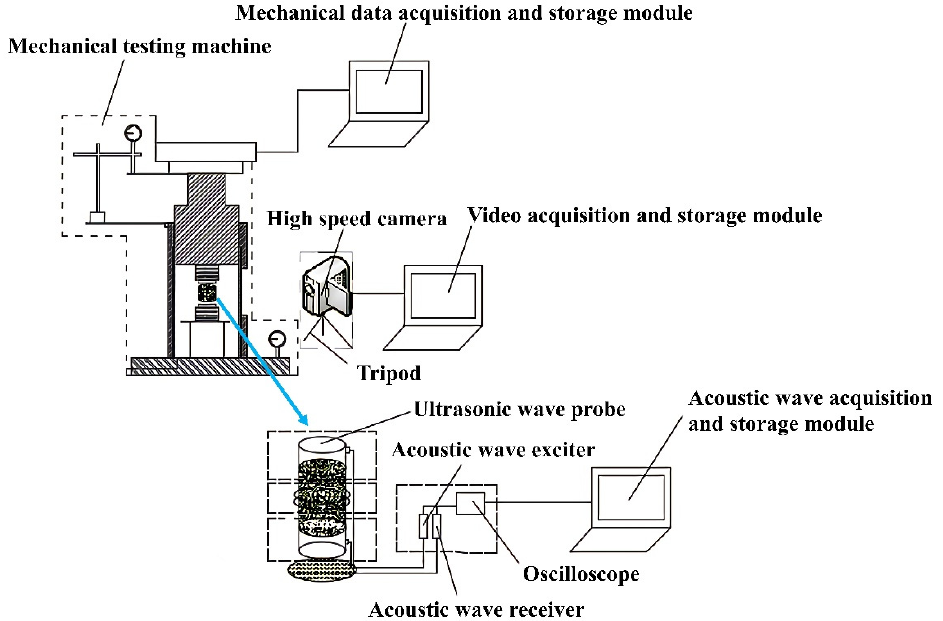
Figure 5. Schematics of multi-parameter monitoring system.